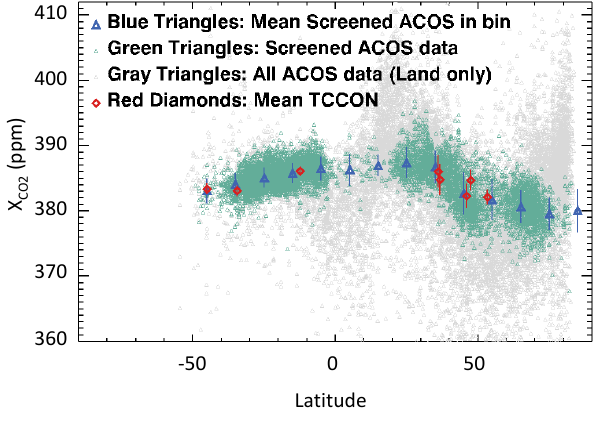
Fig. 16. Same as Fig. 1, but for ACOS GOSAT B2.9. This version of the algorithm incorporates scaled O 2 A-band absorption cross- sections, improved WCO2 cross-sections, corrected ILS interpola- tion, a zero-level-offset retrieval, and other improvements to yield a much better fit to the TCCON results at all latitudes.